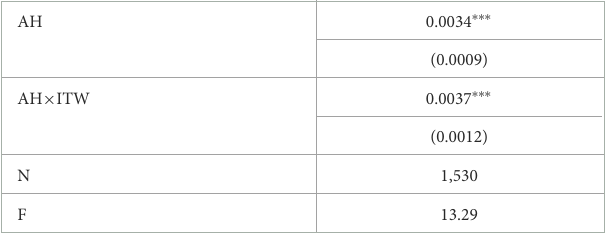
TABLE 5 First stage 2SLS results.